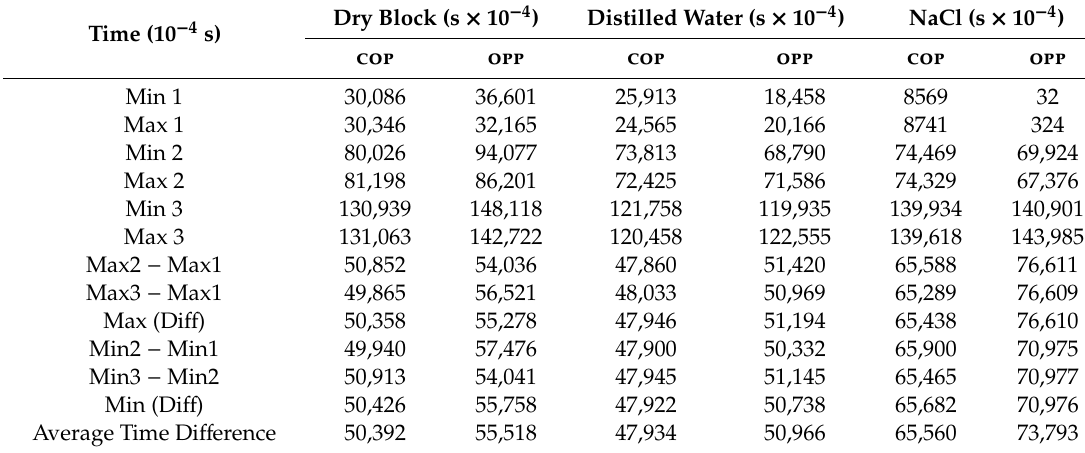
sensors placed coplanarly (COP) and on opposite surface (OPP).